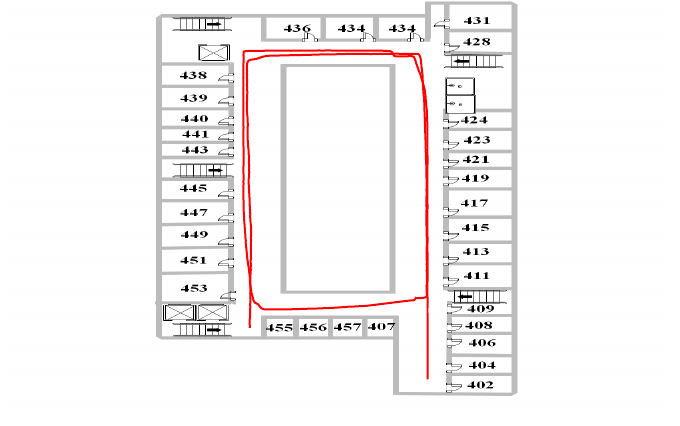
Figure 13. Positioning result for FPF.